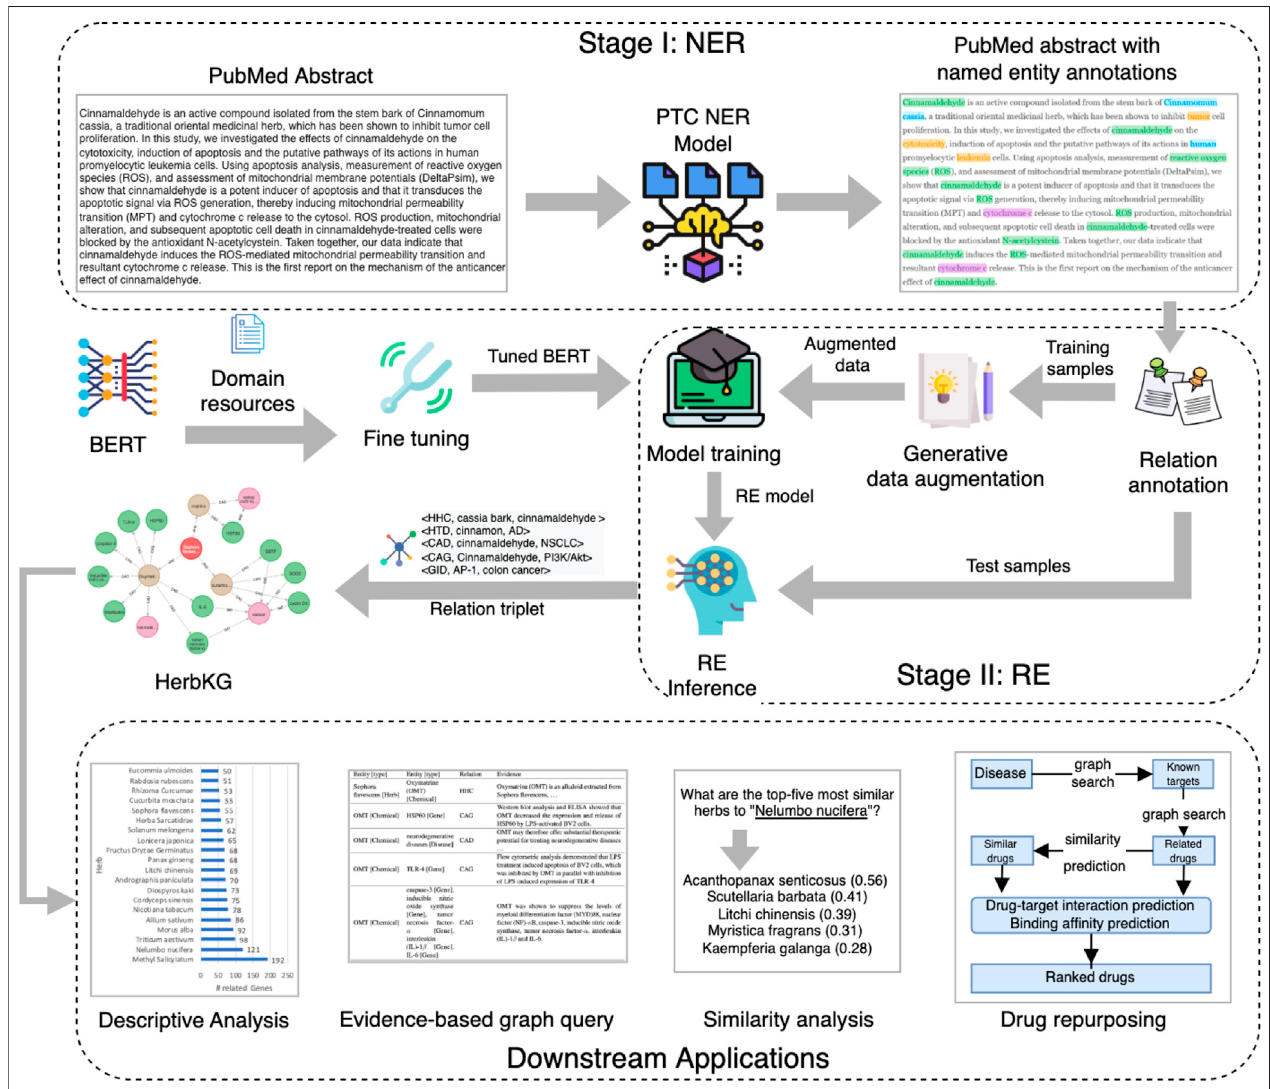
FIGURE 2 | A two-stage learning framework for building HerbKG. Stage I is the NER task, which is done by the PTC NER model. Stage II is the RE task, which extracts relation triplets used to build the HerbKG. In addition, two boosting strategies have been utilized for performance improvement, including fi ne-tuning BERT on domainresourcesandagenerativedataaugmentationmethod.TheformeraimstoinjectdomainknowledgeintotheBERTmodel,whilethelattercangeneratesynthetic samplestoenhancethetraining set.The constructed HerbKG cansupport multipledownstreamapplications, suchasdescriptive analysis,evidence-based graph query, similarity analysis, and drug